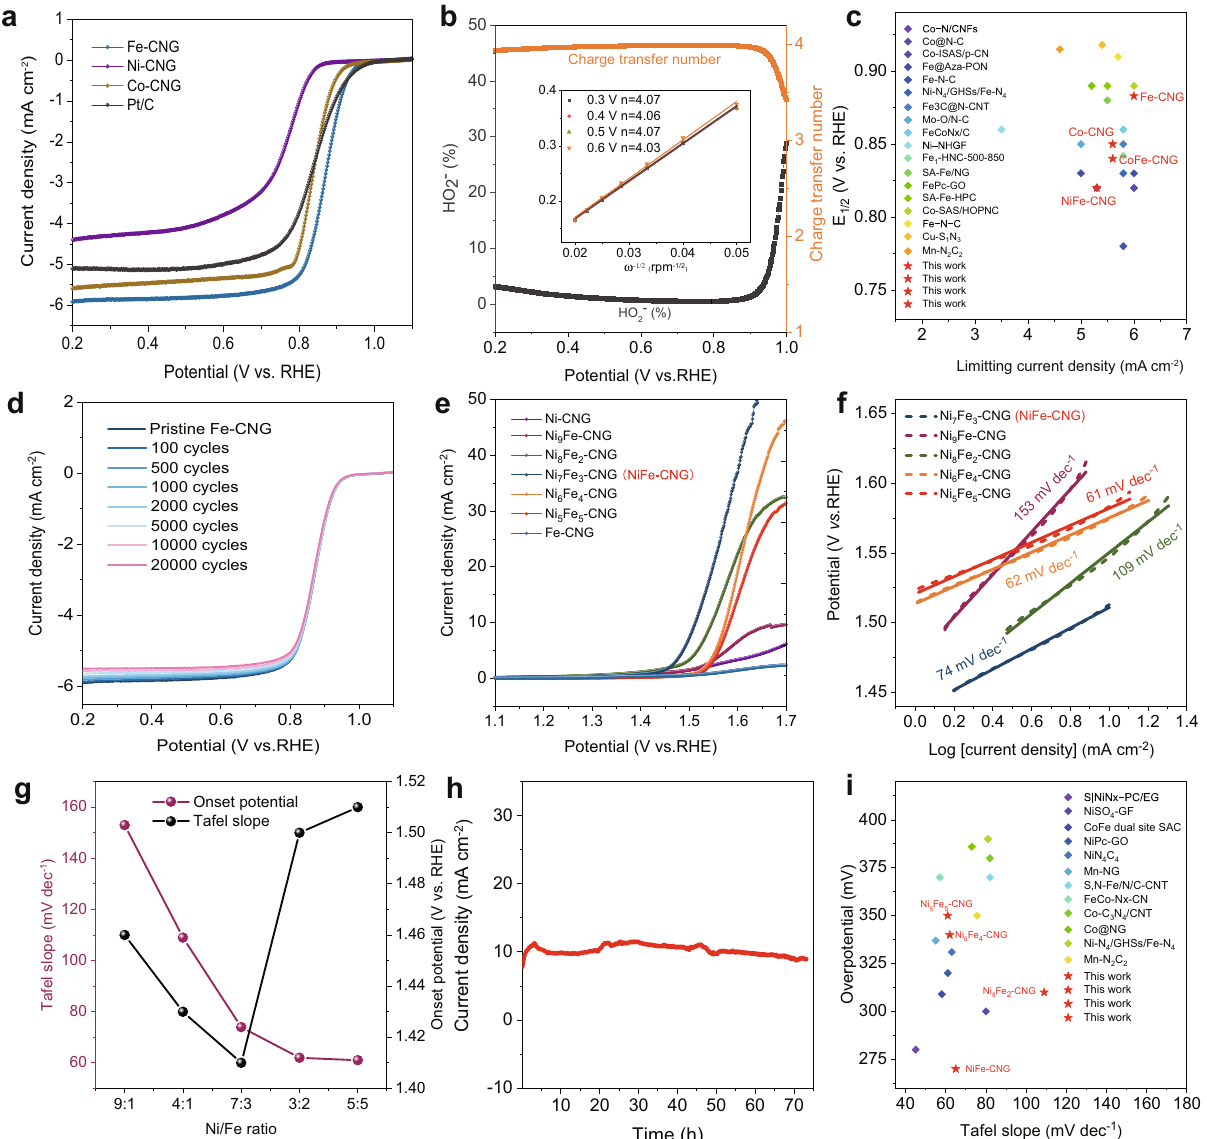
Fig. 3 Electrochemical ORR and OER performances. a ORR polarization curves in O 2 -saturated 0.1 M KOH at a scan rate of 5 mV s − 1 . b HO 2 − yield for ORR and the number of transferred electrons with K – L plots (inset). c Summary of ORR performance of recent representative SACs with their corresponding half-wave potentials and limiting current densities at 1600 r.p.m. d LSV curves after 100, 500, 1000, 2000, 5000, 10,000, and 20,000 CV cycles. e OER polarization curves of NiFe-CNG with different Ni/Fe ratios, and f the corresponding Tafel plots. g In fl uence of Ni/Fe ratios on the Tafel slope and onset potential of OER. h OER stability test of NiFe-CNG loaded on Ni foam. i Recent OER performances of SACs with their corresponding overpotentials at a current density of 10 mA cm − 2 and Tafel slope